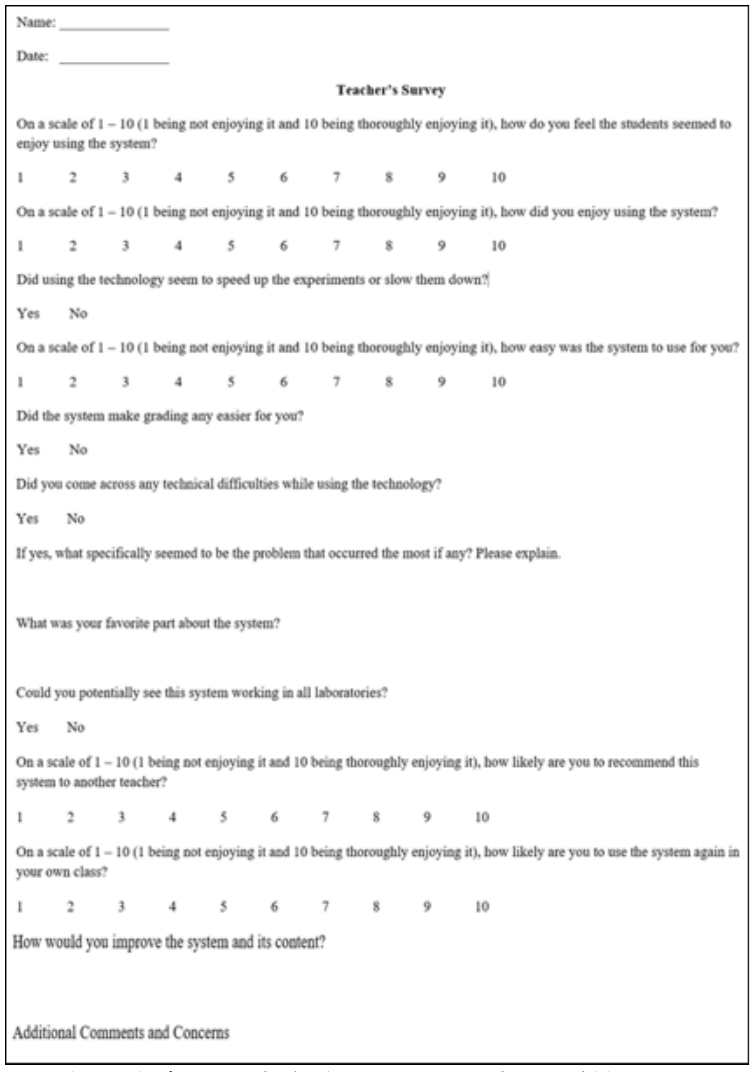
Figure 7. The teacher's survey for both Formation of Hydrogen and Titration